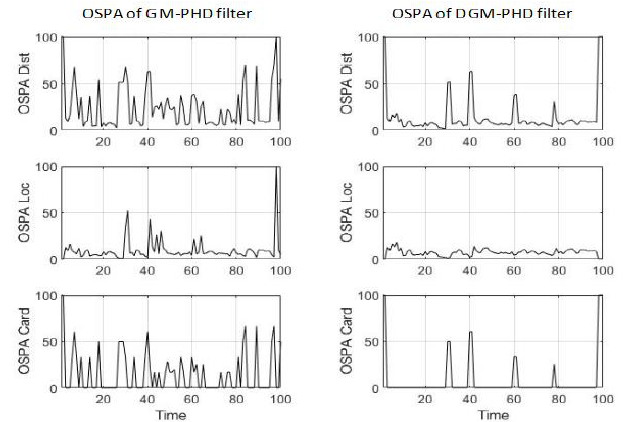
Figure 6. OSPA distance comparison.